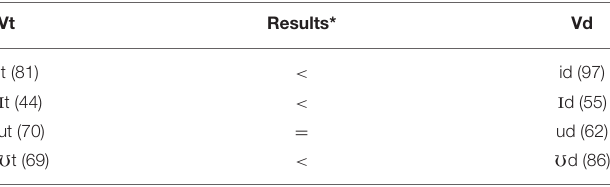
TABLE 6 | Intelligibility of vowels in Vt and Vd rhymes.